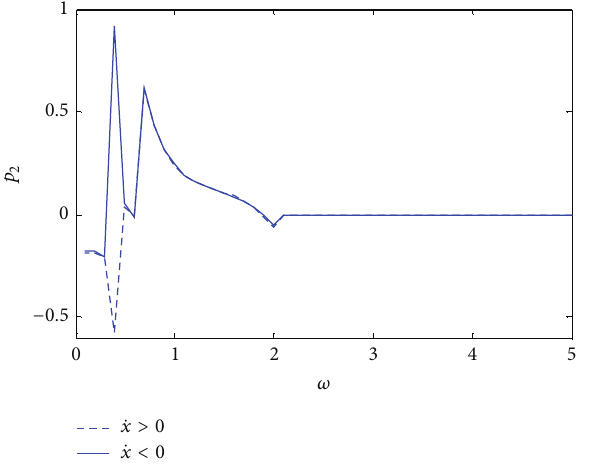
Figure 5: Relationship between 𝑝 2 and 𝜔 .